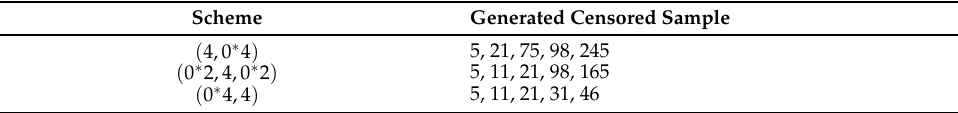
Table 11. Three different PFFC samples from electronic devices dataset.